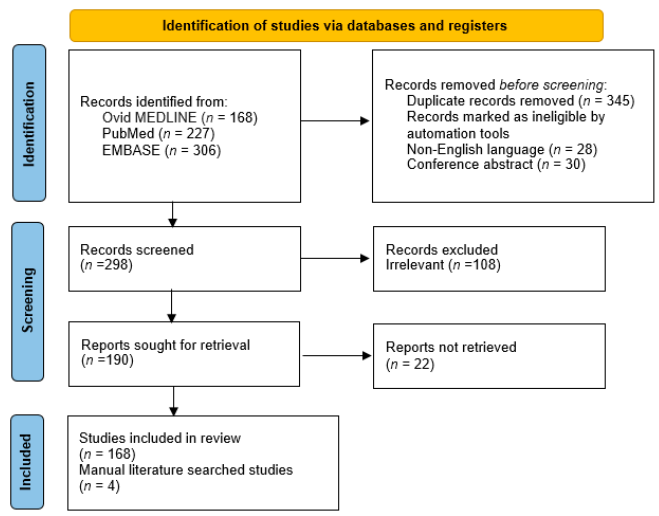
Figure 1. PRISMA flow